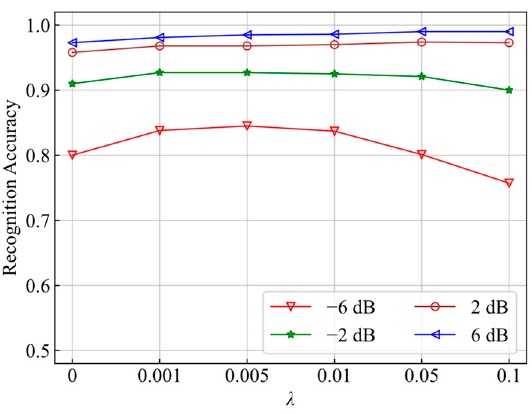
Figure 5. Comparison of recognition accuracy for different values of λ .